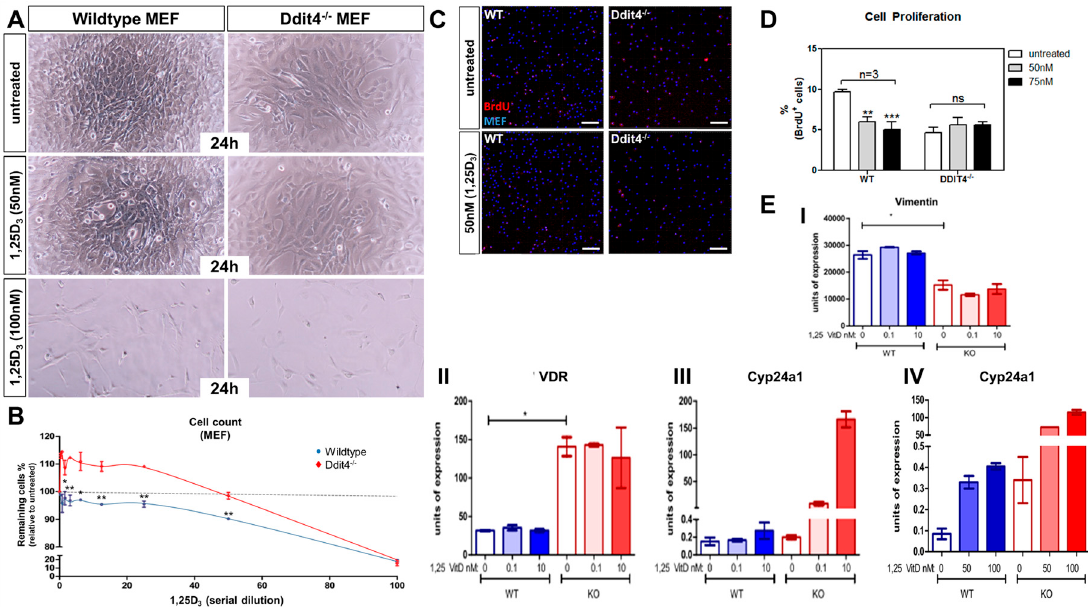
Figure 6. Ddit4 − / − mouse embryonic fibroblasts are resistant to the pro-differentiation actions of vitamin D (1 column). ( A ) Representative images of WT and Ddit4 − / − mouse embryonic fibroblasts (MEFs). MEFs were untreated or treated with a serial dilution of 1,25D 3 (0.39–100 nM) for 24 h; ( B ) Cell counts performed after 1,25D 3 treatment to calculate the proliferation % relative to the untreated sample. One-way ANOVA at an α = 0.05 (95% confidence interval) and Tukey’s multiple comparison post-tests were utilized. Significance is denoted with asterisks: * p < 0.05, ** p < 0.01 ( n = 3